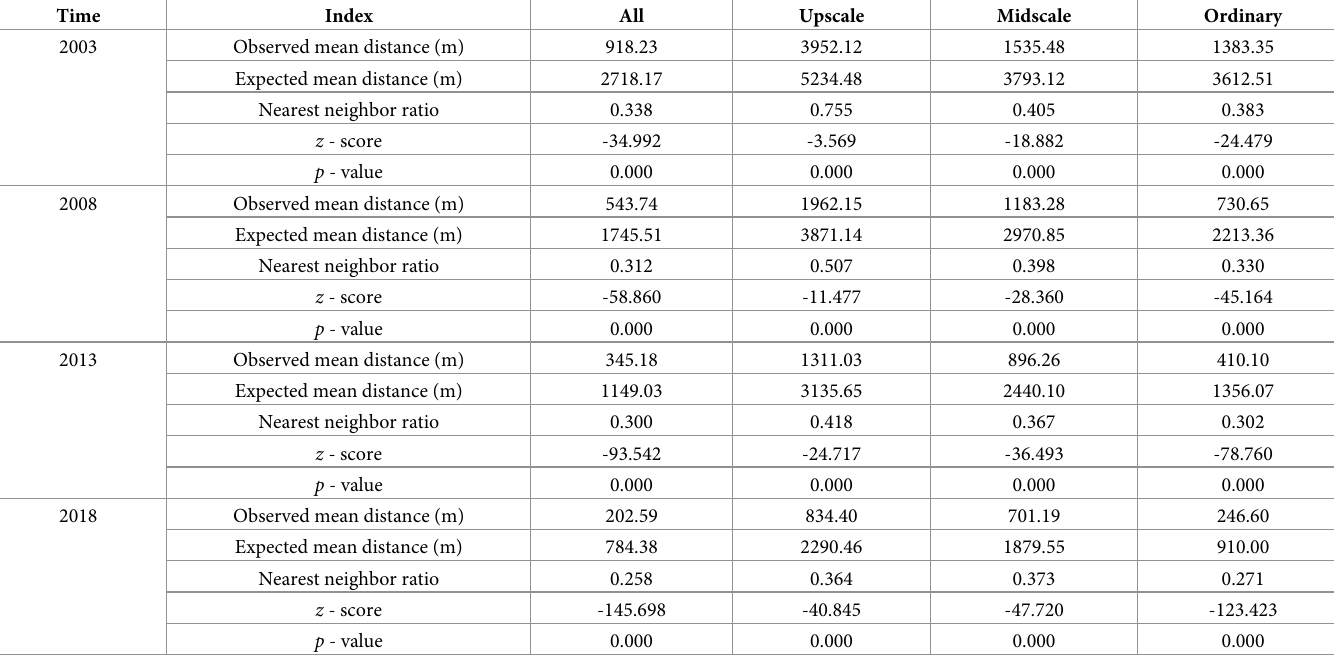
Table 2. The nearest neighbor index of different types of hotels in Beijing from 2003–2018.